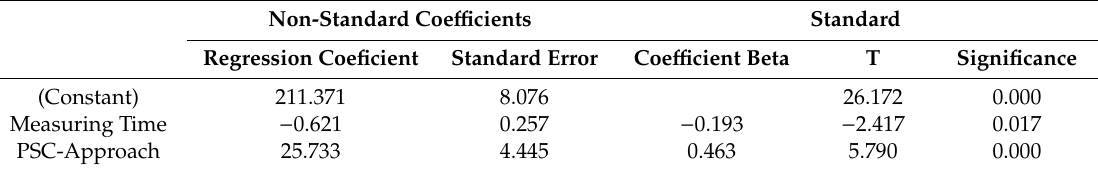
Table 4. Linear regression for substrate disintegration adjusted for the e ff ect of time.